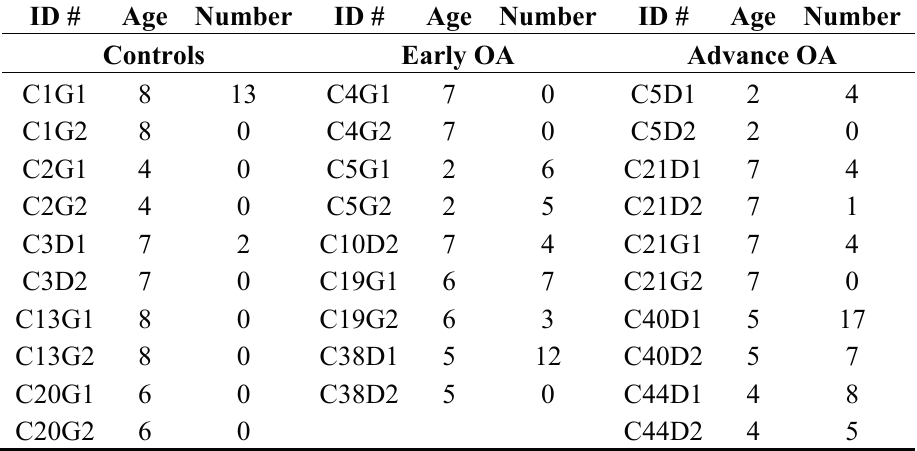
Table 1. Number of images of clusters with HDMI or HDMP spotted by code blind observer. D = Droite = Right. G = Gauche = Left: Last digit 1 = more dorsal 2 = more palmar site. Assignment to Control, EOA and AOA groups was done at the time of the post mortem acquisition of the